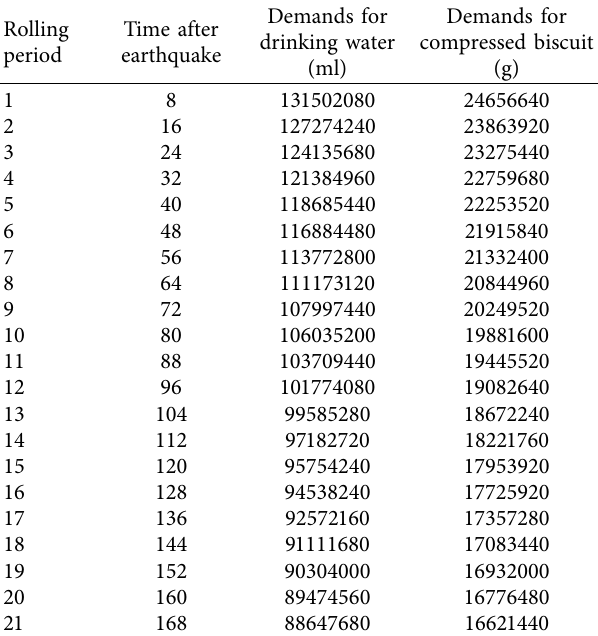
Table 14: Estimations of dynamic material demands in each rolling